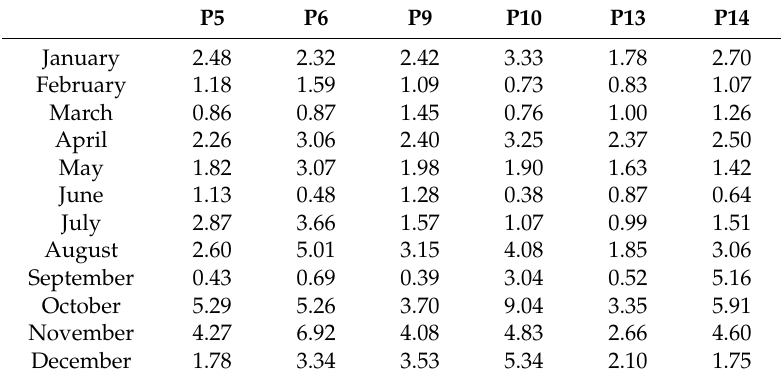
Table 3. Calculated monthly denominator values for JFI (Equation (2)) for Jeddah city in KSA (mm/h). P5 P6 P9 P10 P13 P14